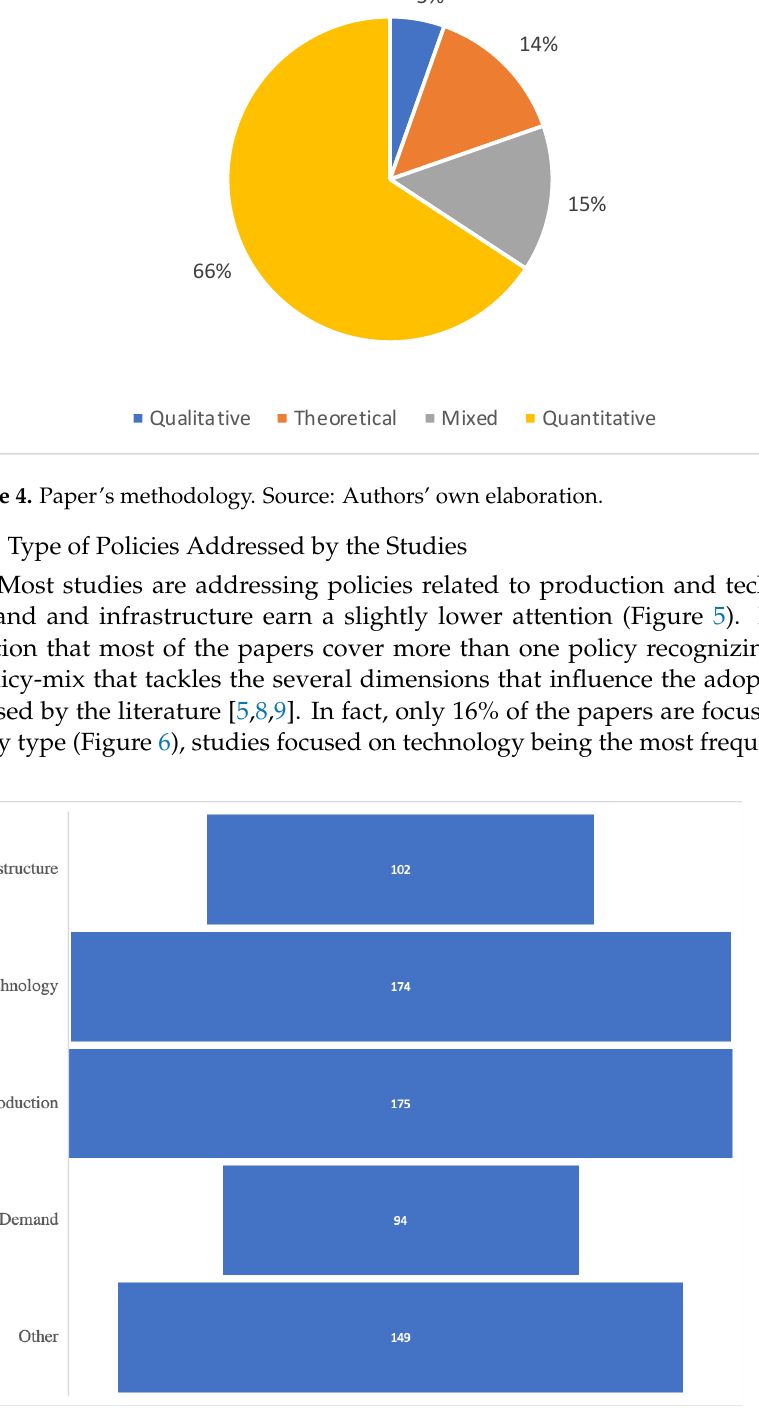
Figure 5. Type of policy considered in the study. Source: Authors’ own elaboration .